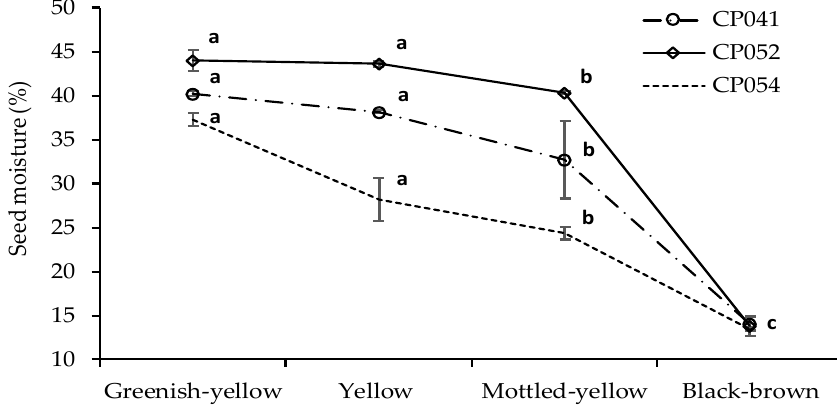
Figure 4. Jatropha seed moisture variation between jatropha INIAP accessions along the fruit ripening stages. INIAP Portoviejo Research Station, Ecuador. Vertical bars indicate the standard error. Different letters indicate a significant difference.